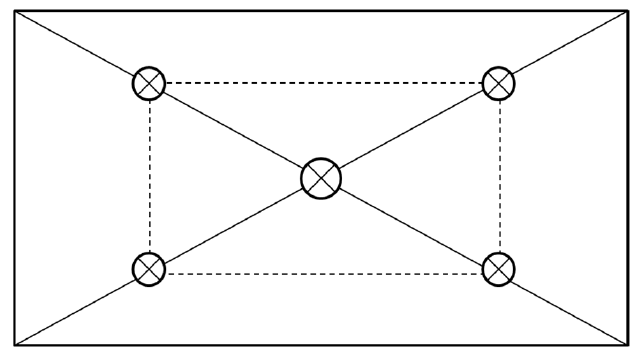
Figure 1. Sample sampling diagram.